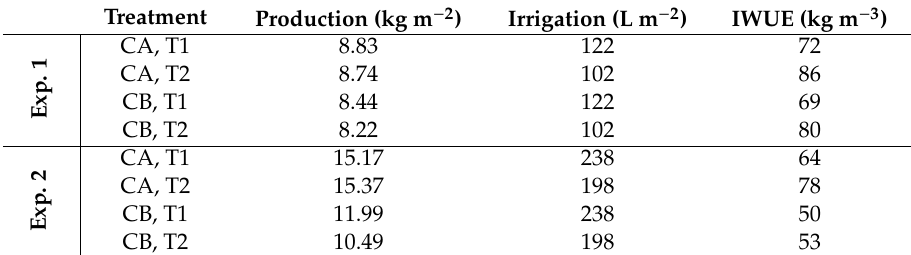
Table 4. Estimation of Irrigation Water Use E ffi ciency (IWUE) based on absolute values of cumulative yield per treatment and total irrigation for Exp. 1 (autumn–winter crop) and Exp. 2 (spring